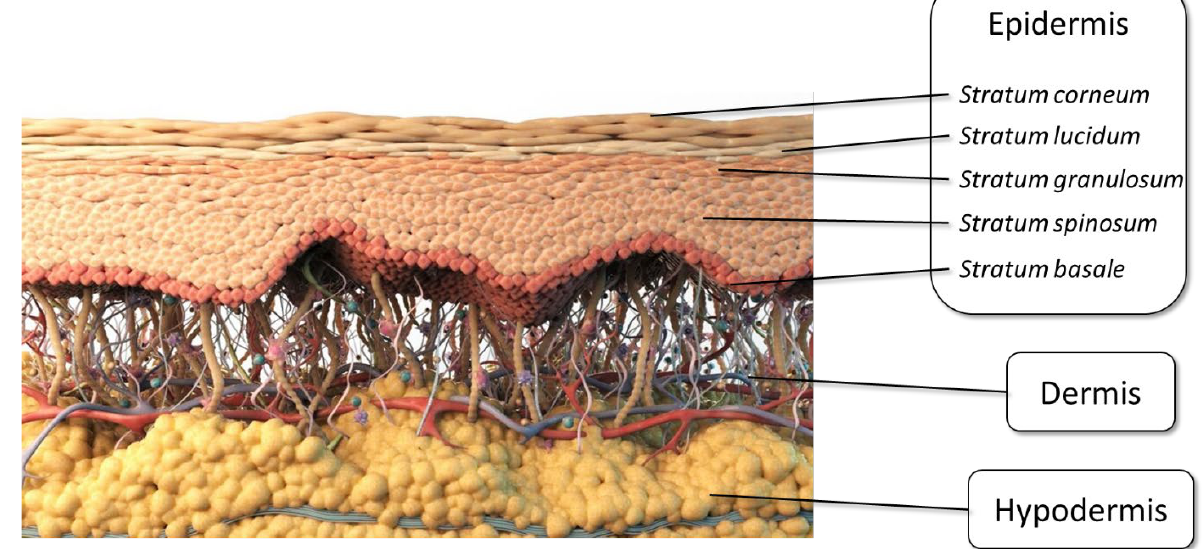
Figure 1. Schematic representation of the skin layers.